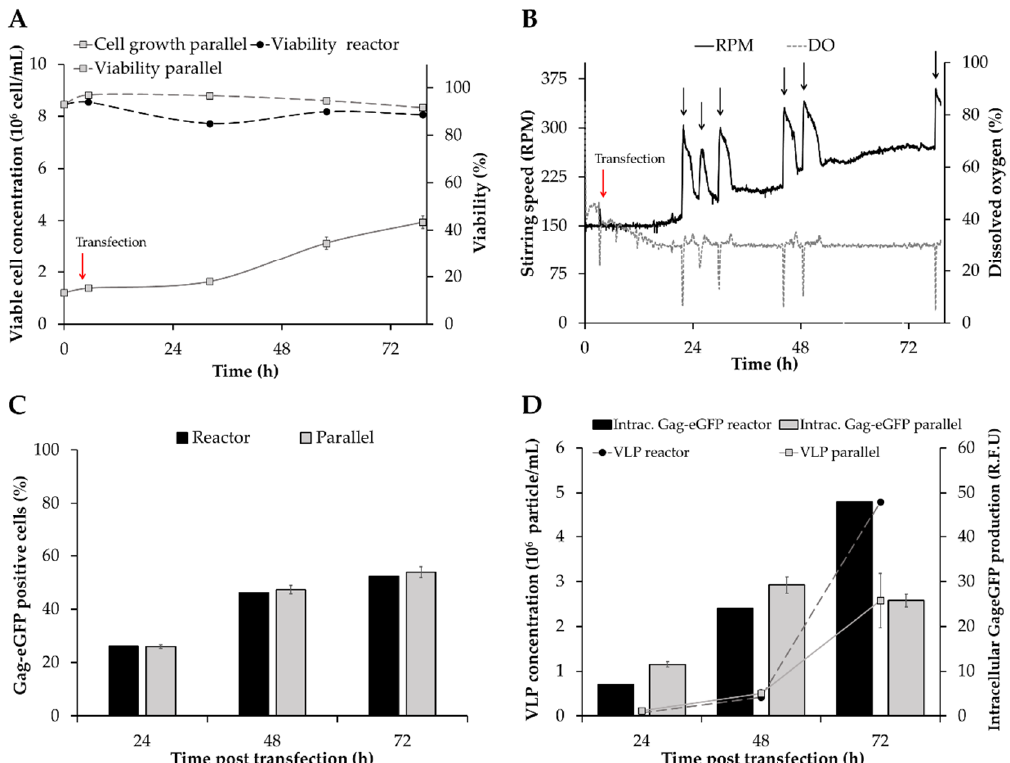
Figure 3. Comparison of Gag-eGFP VLP production in a 2 L DASGIP ® Bioblock glass bioreactor and 125 mL Erlenmeyer flasks (parallel). ( A ) Cell growth and viability profile of transfected cultures. The red arrow indicates the time of transfection. ( B ) Evolution of dissolved oxygen and stirring speed requirements of transfected High Five cells. Black arrows show the addition of Antifoam C. ( C ) Percentage of Gag-eGFP positive cells at di ff erent time points. ( D ) Analysis of VLP production and intracellular Gag-eGFP content by flow virometry and spectrofluorometry, respectively. Mean values ± standard deviation of triplicate experiments are